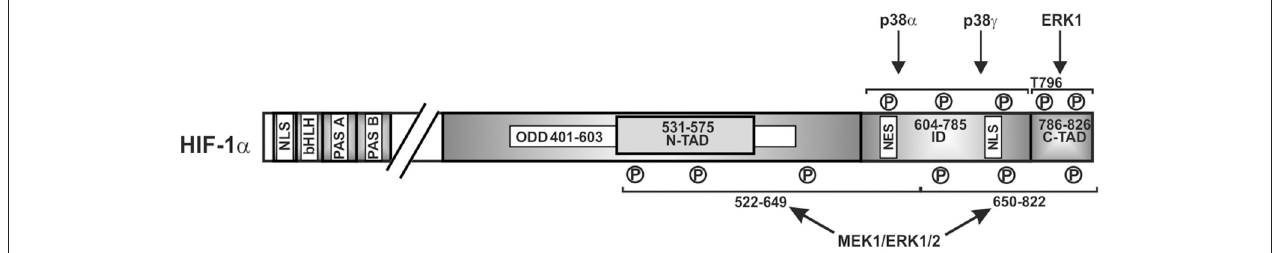
FIGURE 4 | Kinases involved in regulating HIF-1 α transactivity. Scheme of HIF-1 α and its domains in which phosphorylation has been shown to affect transactivity. P, represents a phosphorylated amino acid, no specific single residues sites have been mapped. ERK1/2, extracellular regulated kinase1/2; bHLH, basic